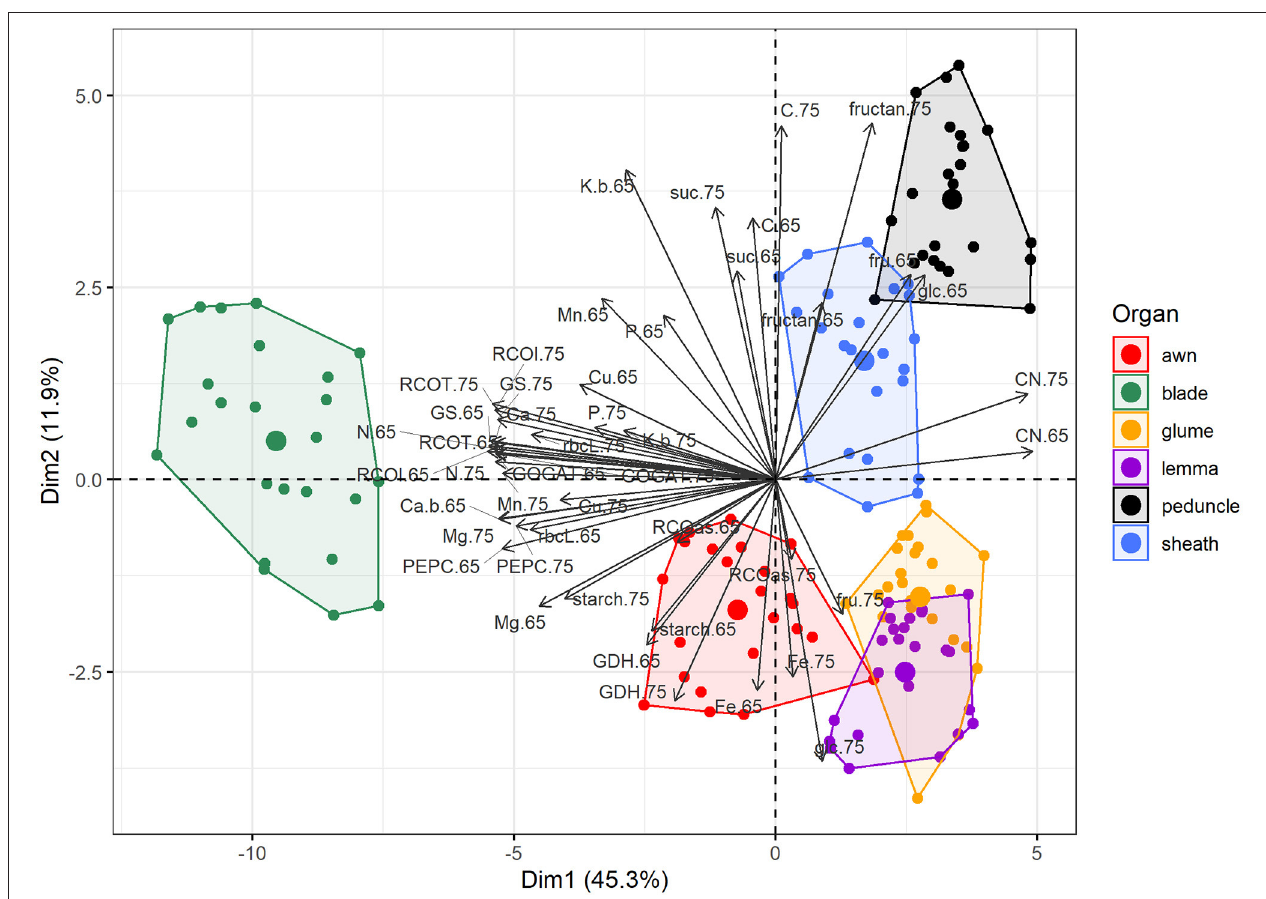
FIGURE 6 | Principal component analysis of metabolites, enzyme activities, and nutrient composition in different organs (blade, sheath, peduncle, awn, glume, and lemma) in field-grown durum wheat. The abbreviations are described in Supplementary Table 1